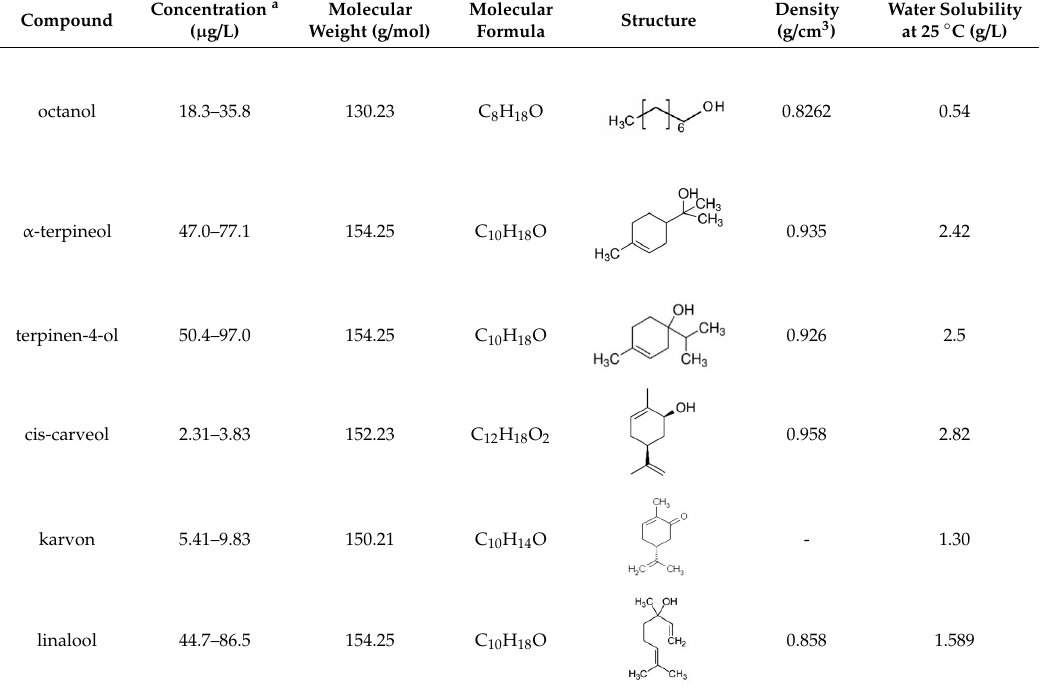
Table 1. Properties of aroma compounds and their concentration in condensed water from thermally evaporated orange juice.